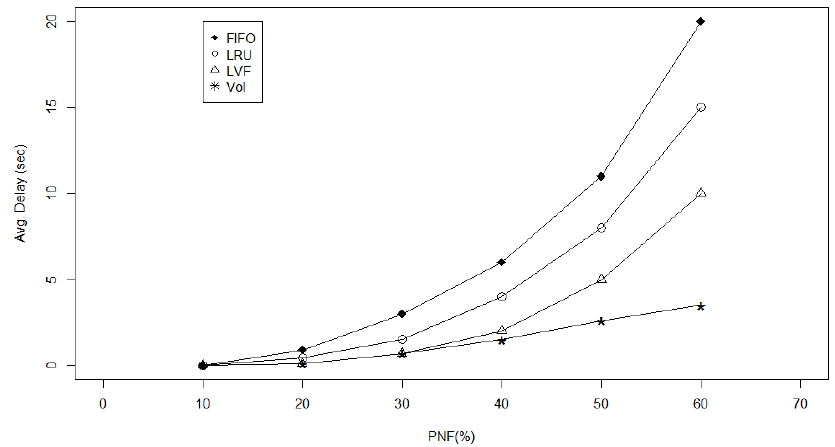
Figure 13. Average delay versus the probability of node failure in the network.